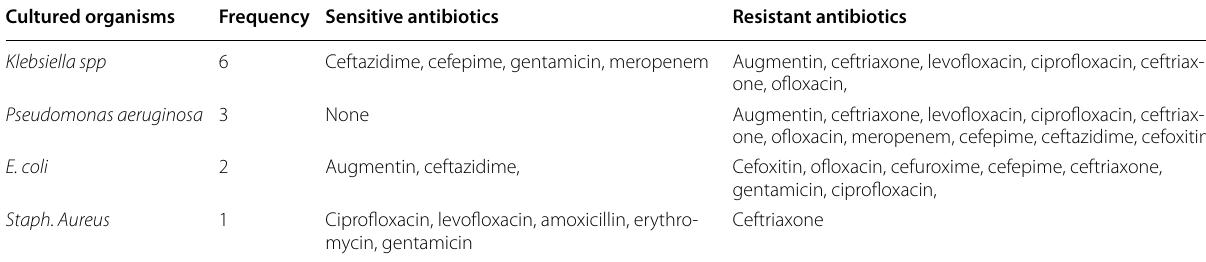
Table 4 Bacterial isolates in group 2 (test group) and antibiotic sensitivity pattern from urine culture Cultured organisms